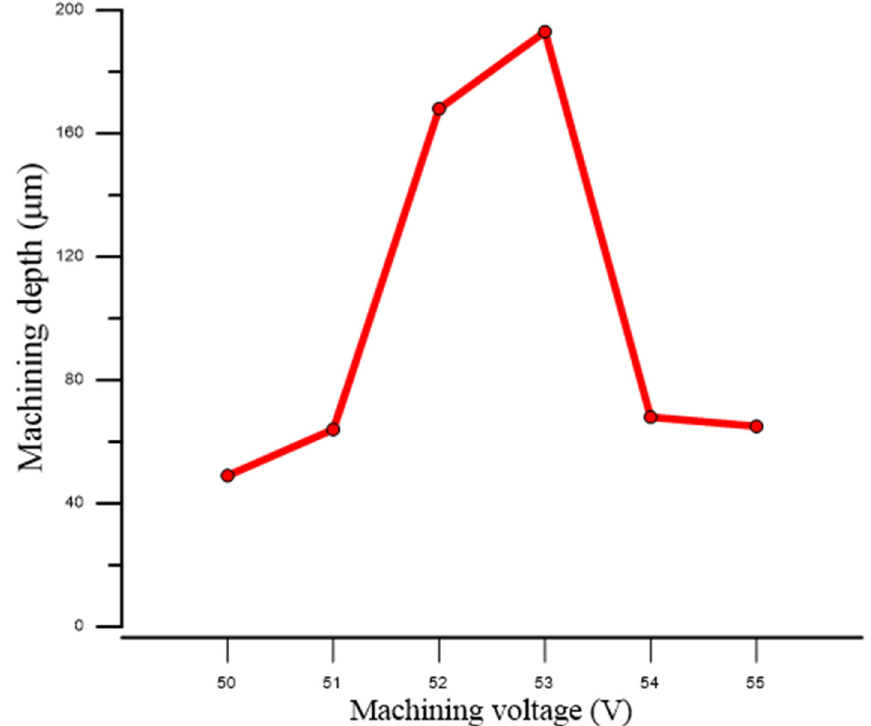
Figure 11. The machining voltage and machining depth relationship diagram for the use of the combinational machining method to perform machining of sapphire.